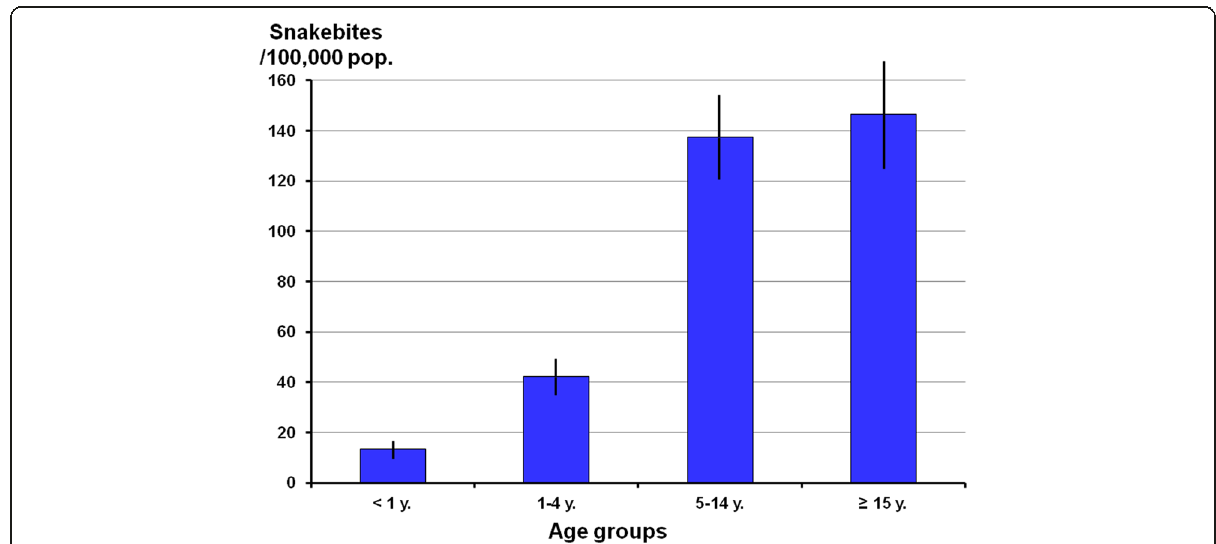
Fig. 1 Annual specific incidence of snakebites per 100,000 people according to the age